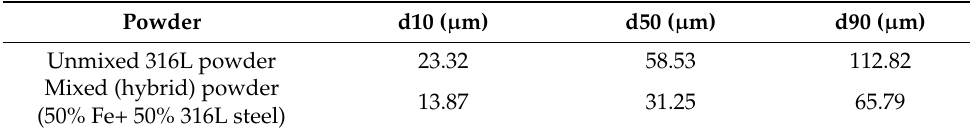
Table 4. Particle size distribution of unmixed and mixed (hybrid)